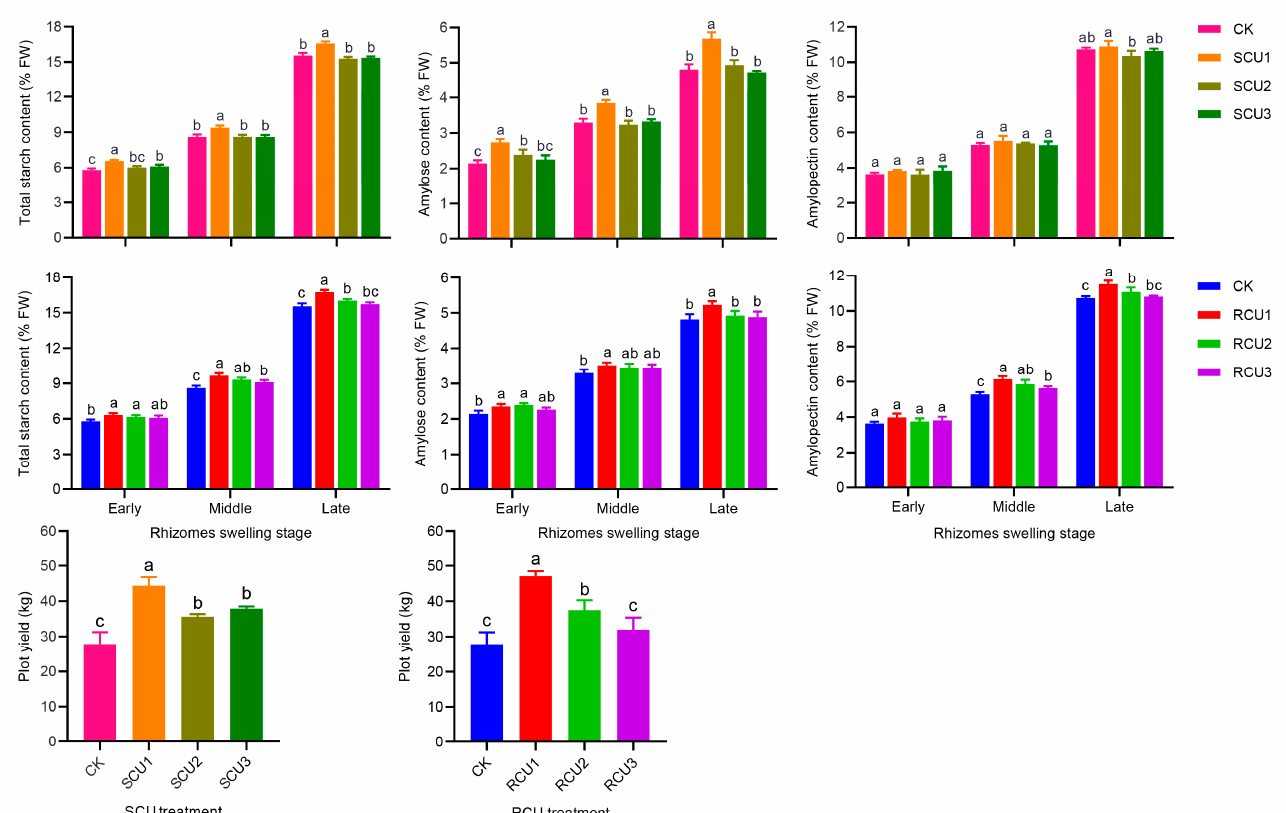
Figure 3. Starch content and yield under SCU and RCU treatment. Different letters indicate a significant difference in starch content and yield at the swelling stage of the lotus rhizome between different treatments at the 5% level. Error bars show standard deviation (SD) from three biological replicates. Table 2. Starch content and yield under SCU and RCU treatments.